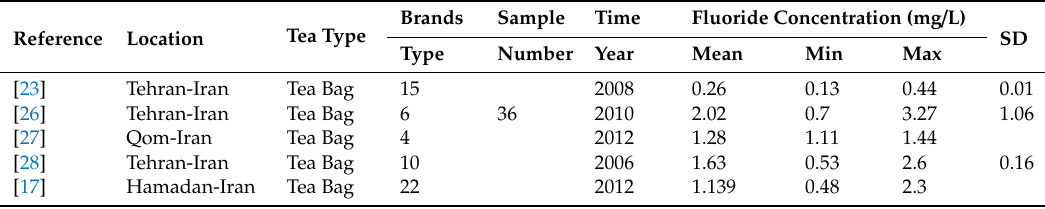
Table 1. General information of the related